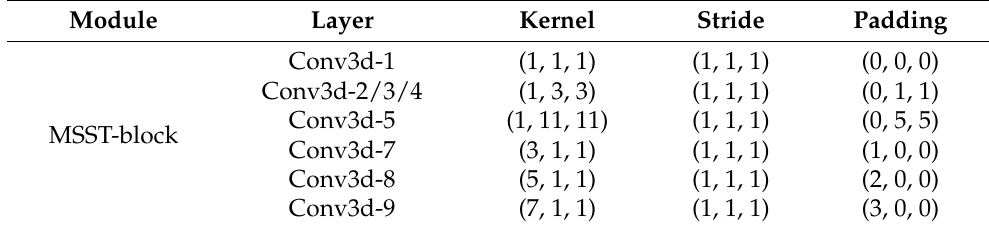
Figure 4. The MSST unit’s internal structure. Table 2. Architecture of 3D convolution in module